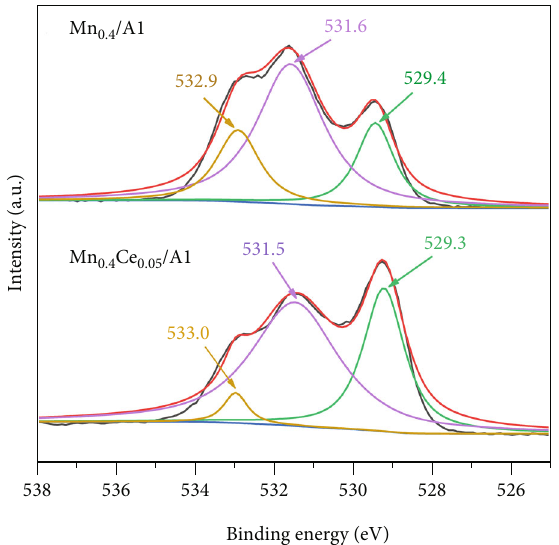
Figure 5: XPS spectra for O 1s of (a) the Mn